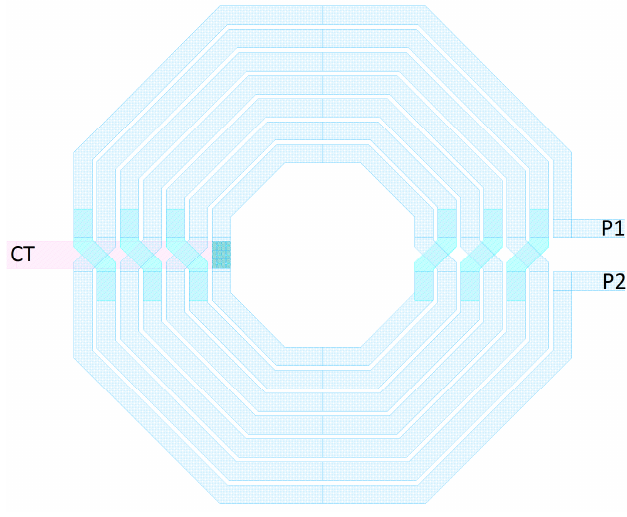
Figure 4. Layout of the symmetrical inductor L D1 .